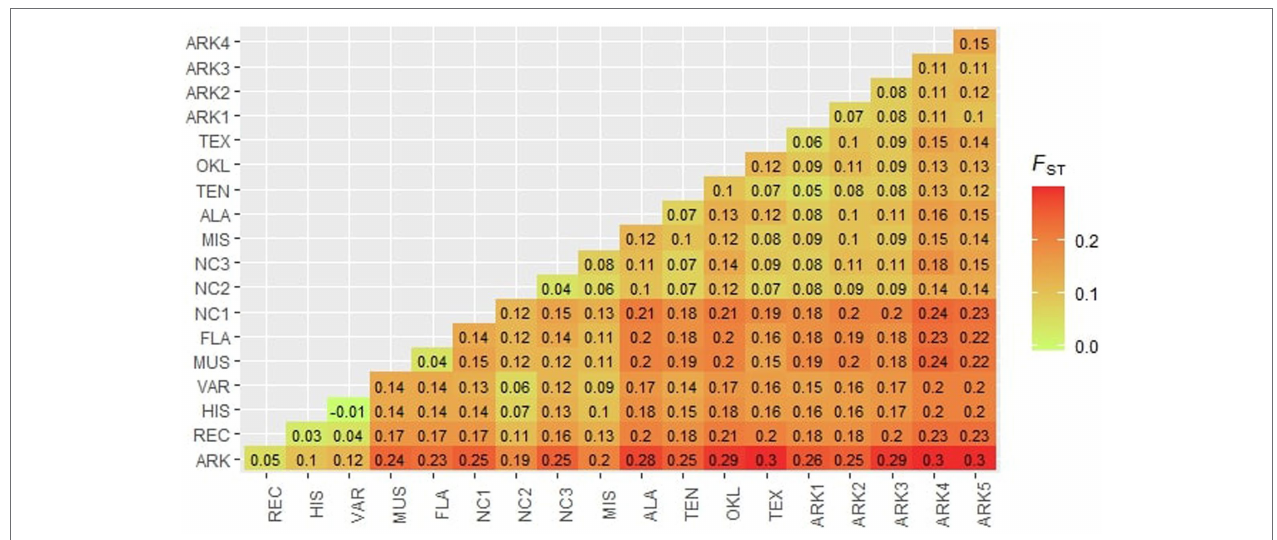
FIGURE 4 | Pairwise F ST values calculated for each population following Weir and Cockerham